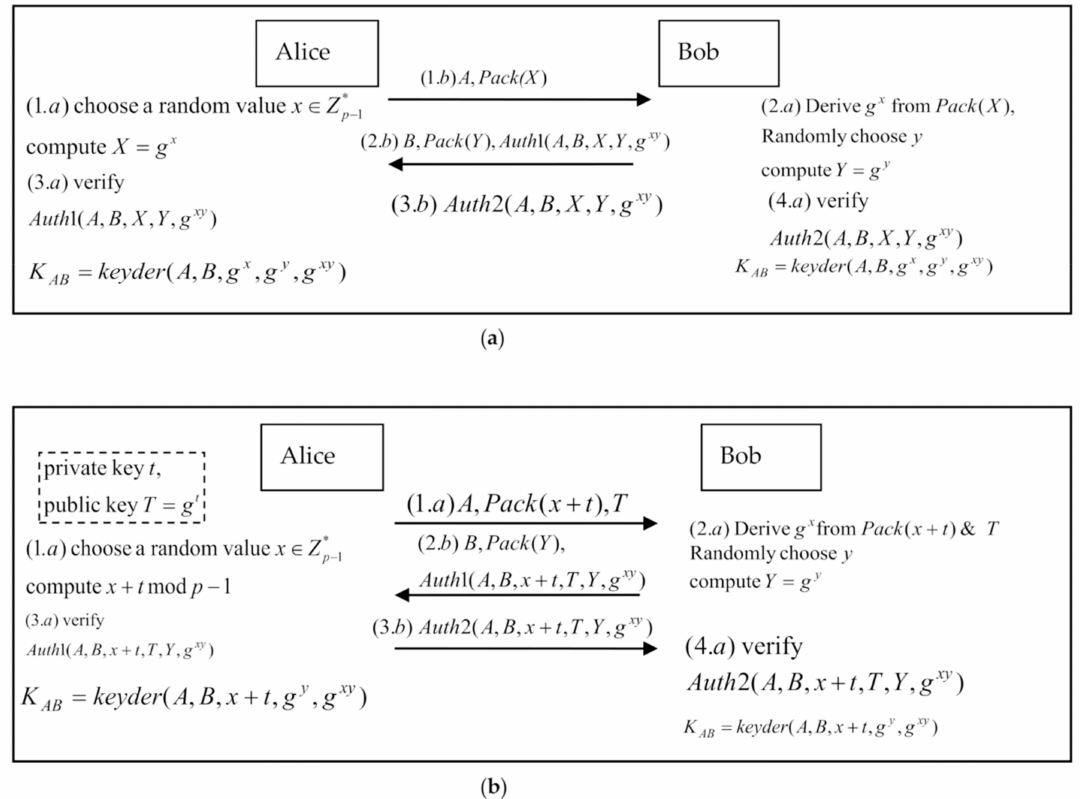
Figure 1. ( a ) The conventional authenticated D-H key agreement. ( b ) The MCDHP-based authenticated D-H key agreement with enhanced client